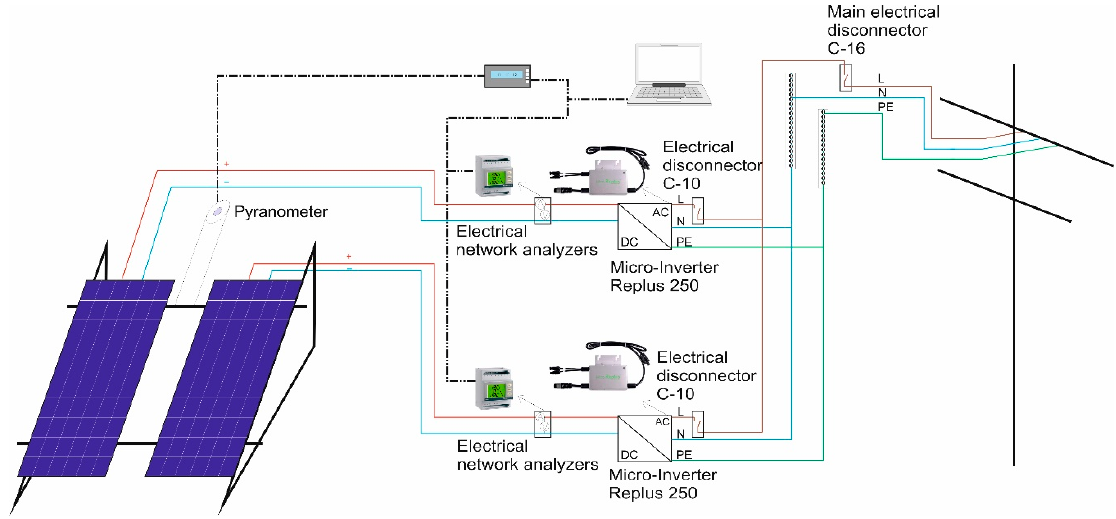
Figure 2. Scheme of the test stand with all components used to the tests.